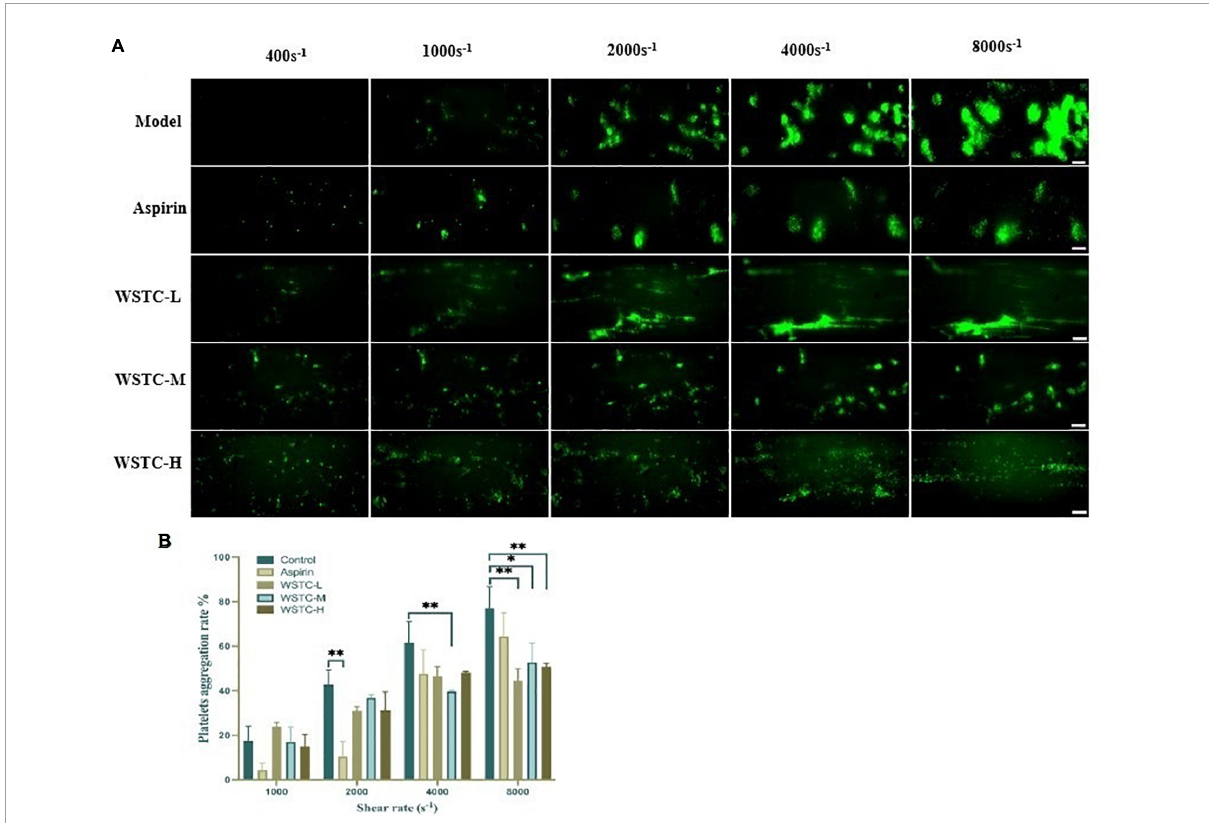
FIGURE1 Effects of water-soluble tomato concentrate (WSTC) on shear-induced platelet aggregation. (A) Representative images showing effects of Model group and groups treated with WSTC at 0.7 g · L − 1 (WSTC-L), 2.0 g · L − 1 (WSTC-M), or 6.0 g · L − 1 (WSTC-H) and Aspirin (1 mM) on platelet aggregation under shear rates of 400, 1,000, 2,000, 4,000, and 8,000 s − 1 . The scale bar is 50 µ m. (B) Mean platelet aggregation rate at the end of exposure indicated shear rates under the conditions shown in (A) . ∗ P < 0.05 and ∗∗ P < 0.01, compared to control group, analyzed by two-way ANOVA